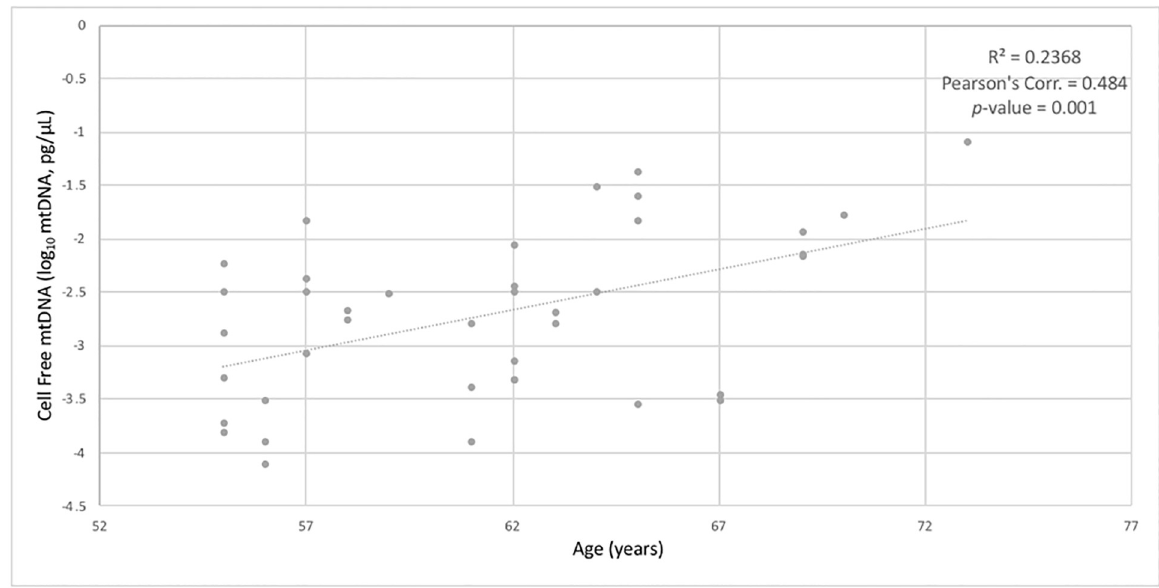
Fig 3. Correlation between cell-free mtDNA and age. Pearson’s correlations showing significant relationships between cell-free mitochondrial DNA levels and age (p-value = 0.001).